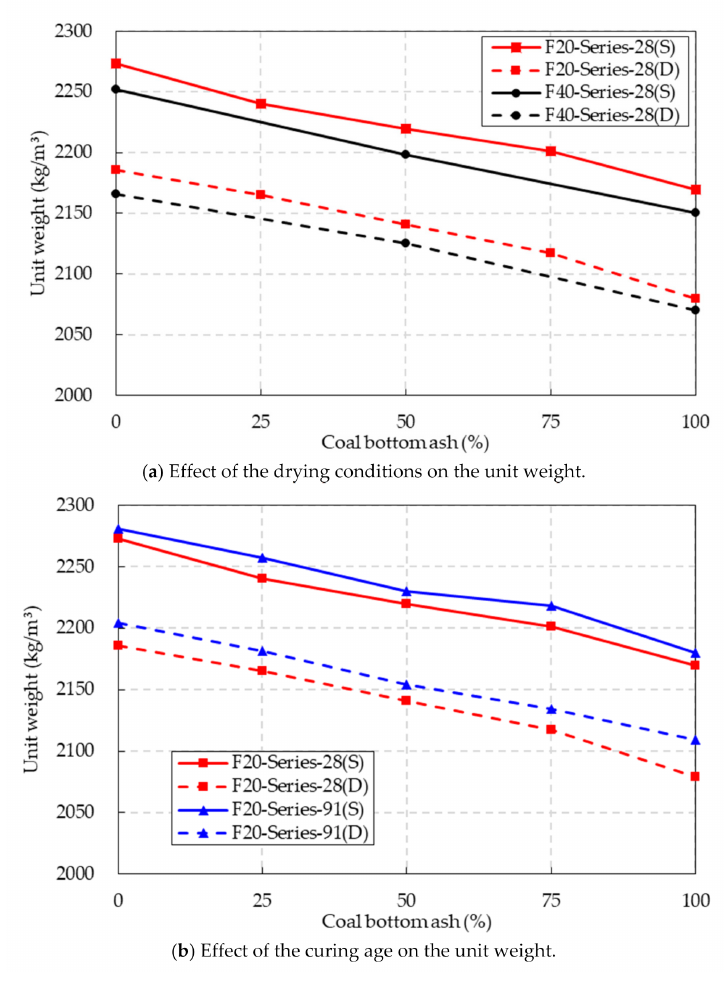
Figure 5. Unit weight test